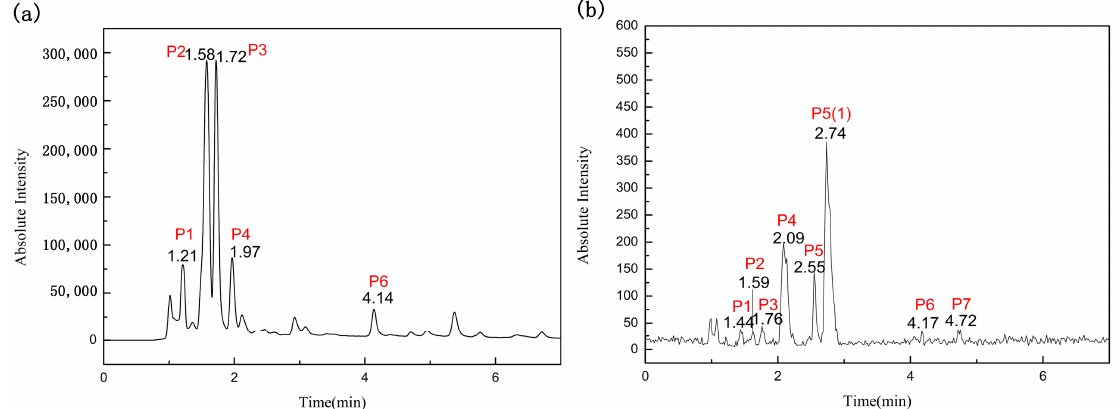
Figure 2. UPLC chromatogram (five peaks) ( a ) and total ion chromatogram (seven peaks) ( b ) at 254 nm (here are shown only intercept chromatograms for the first 7 min because there was no peak after then).